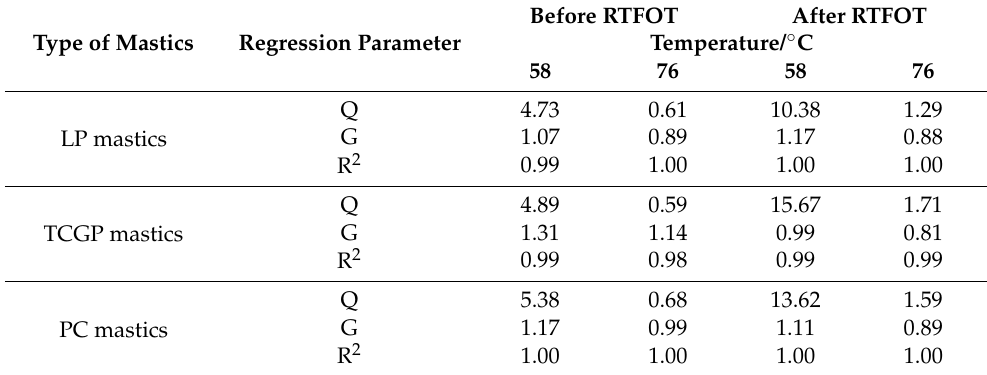
 After RTFOT Figure 7. Effect of filler type and F/B on * / sin G  of emulsified asphalt mastics (76 ℃ ). Figure 7. Effect of filler type and F/B on G ∗ / sin δ of emulsified asphalt mastics (76 ◦ C). Table 6. Regression Relationship between G ∗ / sin δ and F/B of emulsified asphalt mastics. Before RTFOT After Type of Mastics Regression Parameter